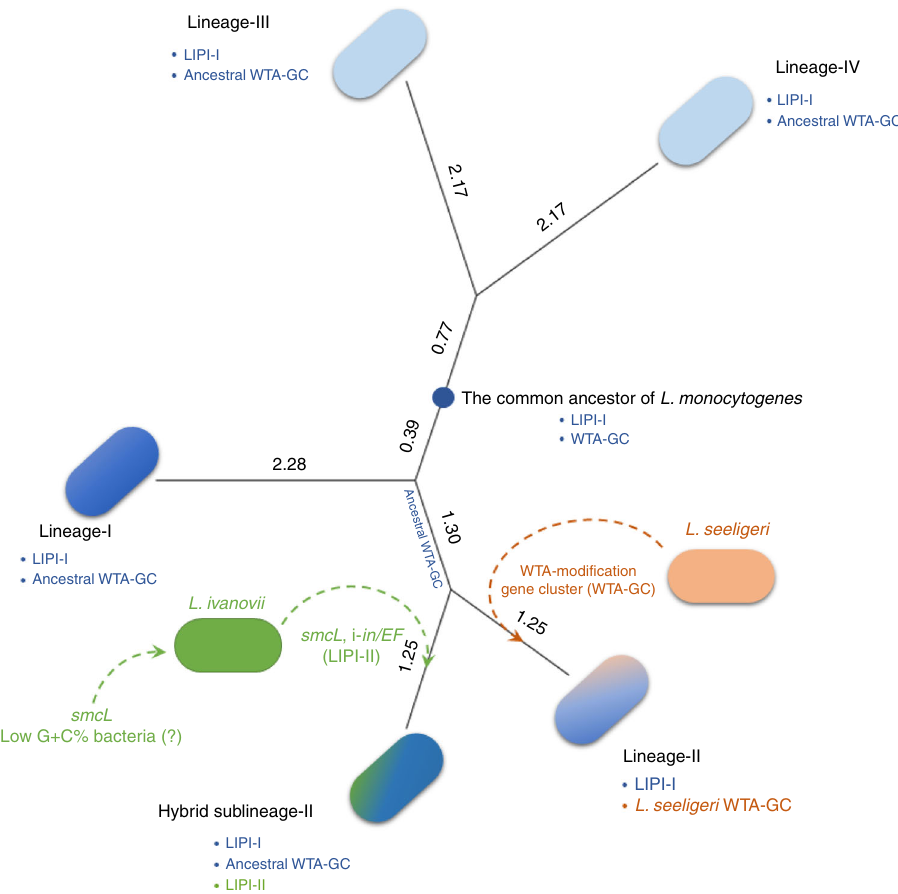
Fig. 8 Evolutionary model of L . monocytogenes HSL-II. The phylogram is constructed using MUMmer-based average nucleotide identity (ANIm) of closed genomes of all lineages. The lineages are proposed to originate from a common ancestor possessing a 4b-like wall teichoic acid gene cluster (WTA-GC). For Lineage II, subsequent recombination events led to replacement of WTA-GC from L . seeligeri . Lineage II and HSL-II then separated and followed independent evolutionary paths. Ecological coexistence of HSL-II with other Lm lineages and L . ivanovii led to exchange and acquisition of genetic clusters, including a partial LIPI-II locus. The number next to each clade represents the %ANIm difference from respective last common ancestor. The topology of the tree is identical to the phylogenomic tree calculated based on the core genome (as in Fig. 2). WTA-GC: wall teichoic acid gene